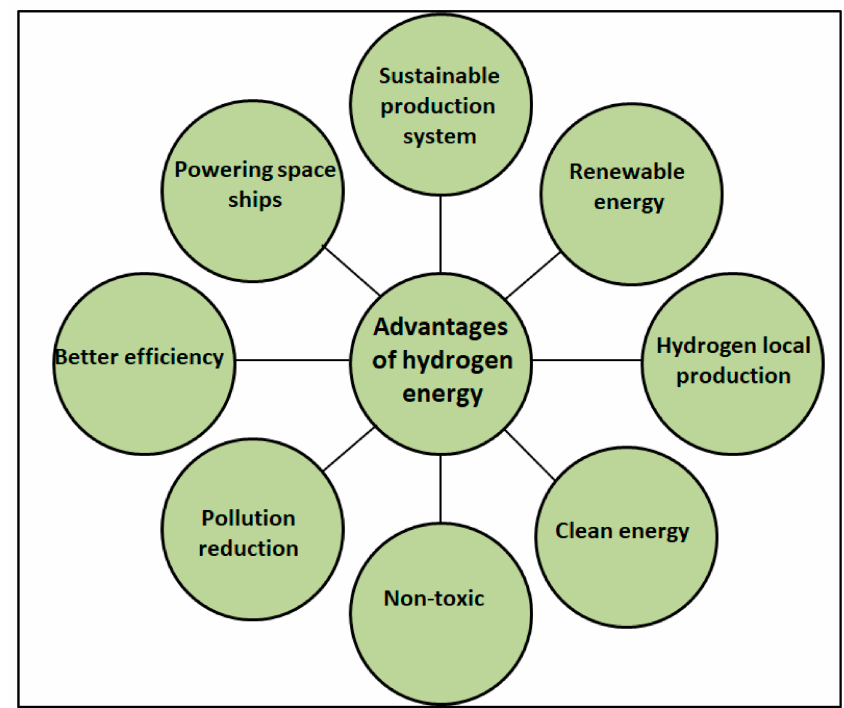
Figure 1. Advantages of hydrogen